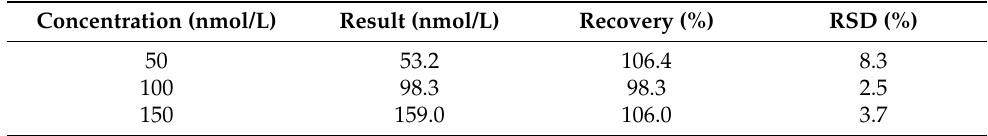
Table 2. Determination of Pb 2+ in lake-water samples (n =